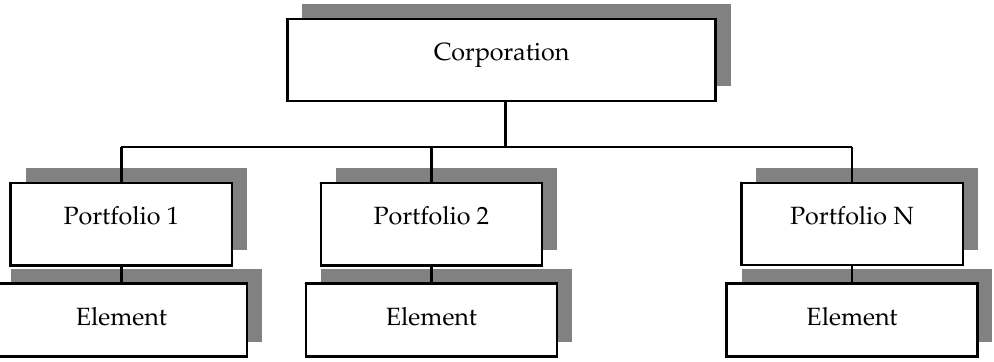
Figure 1. Property portfolios of the corporation.